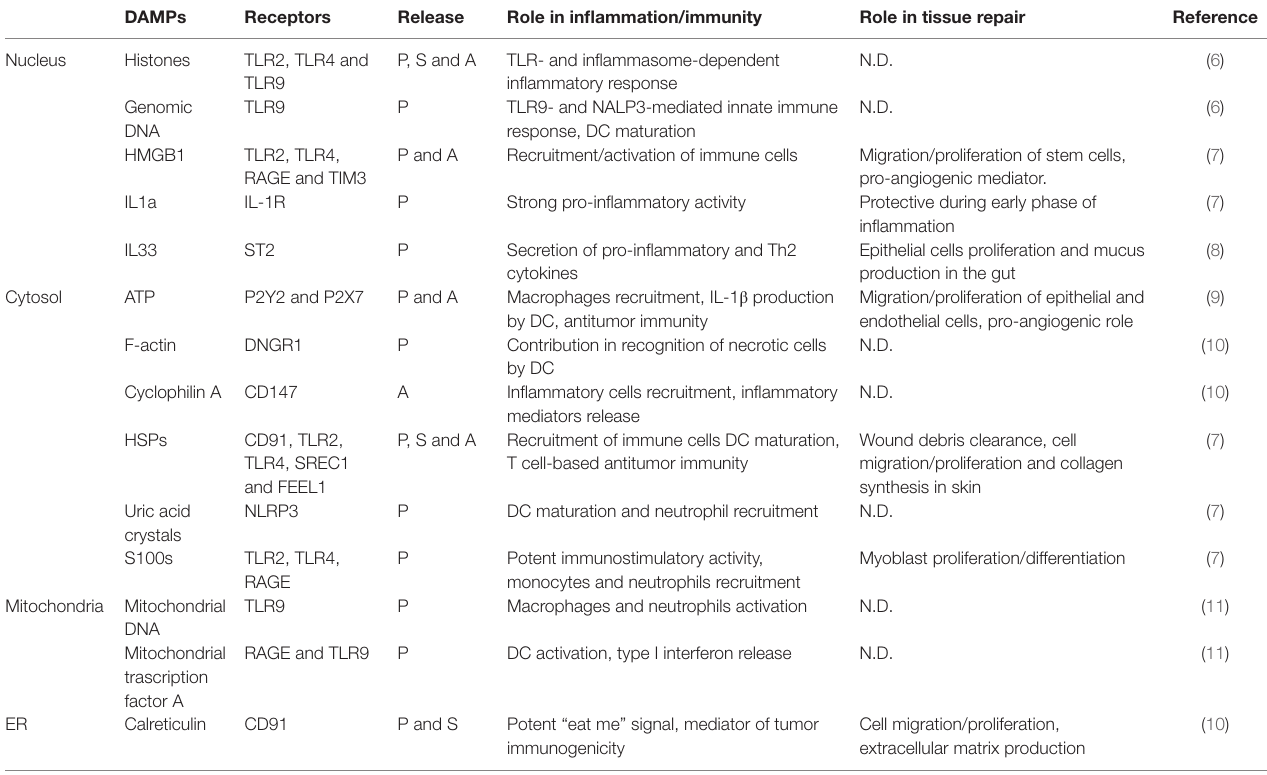
TABLe 1 | List of putative DAMPs and role in inflammation and tissue repair.